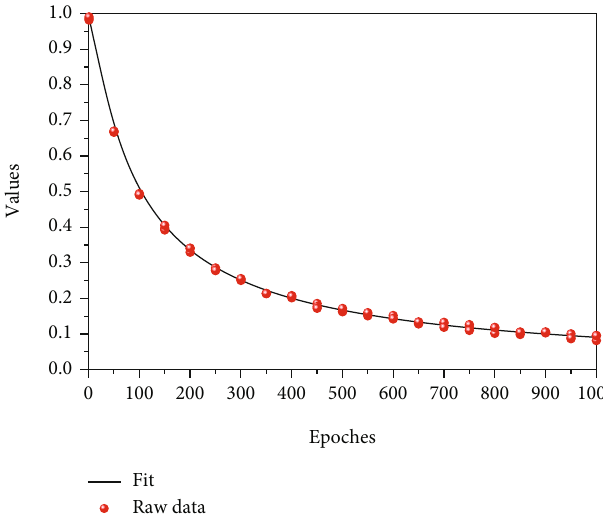
Figure 6: Loss functions of di ff erent datasets during